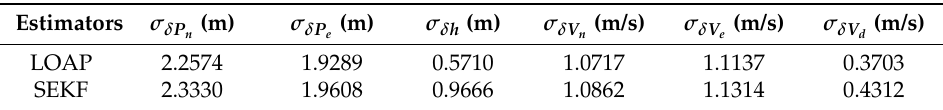
Table 3. A standard deviations of estimated errors comparison between multi measurement modes based LOAP and single mode EKF.